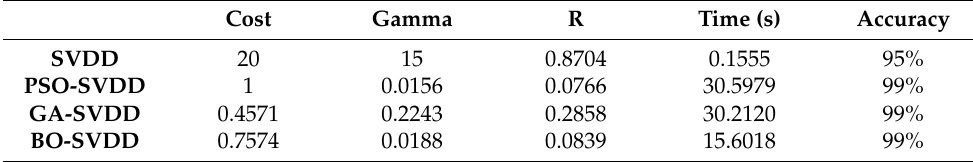
Table 3. Parameters and results of the experiment.